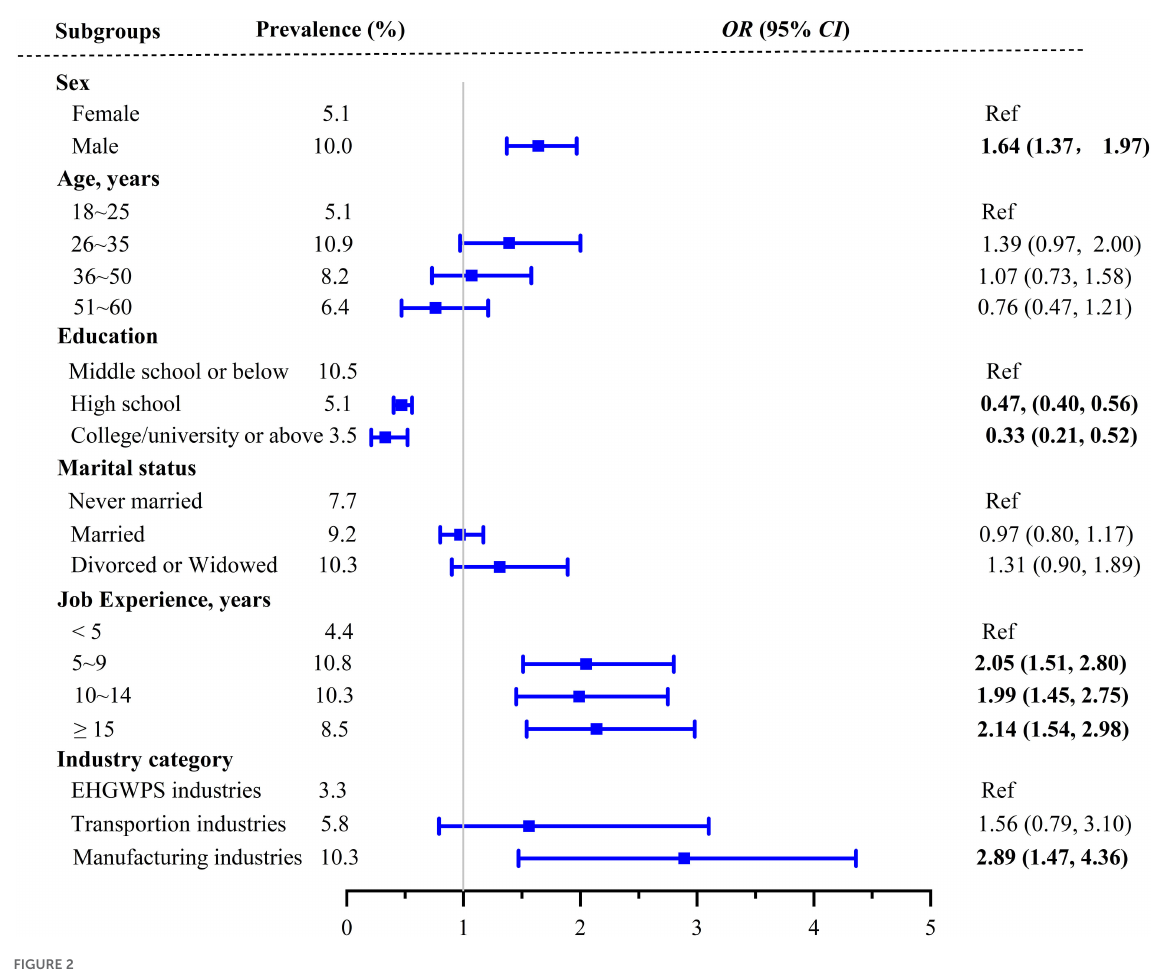
workers were higher than those of younger workers.